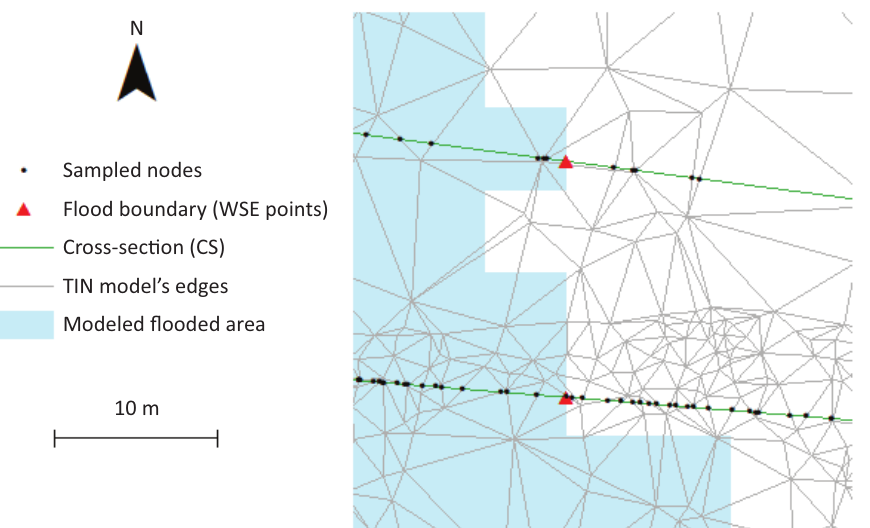
Figure 1. Sampled nodes (black points) are derived by intersecting the TIN model’s edges and the CS. WSE points (red triangles) are derived where the flood boundary intersects the CS.